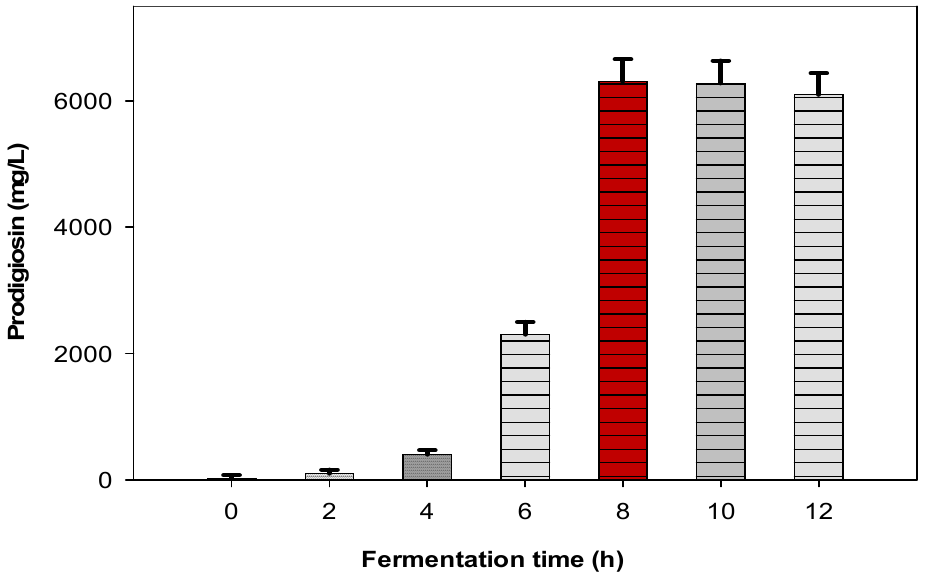
Figure 2. Scale-up of PG production to a 12 L-bioreactor system. Standard errors (SE) are shown as error bars. The red bar indicates that PG reached maximal yield at 8 h of